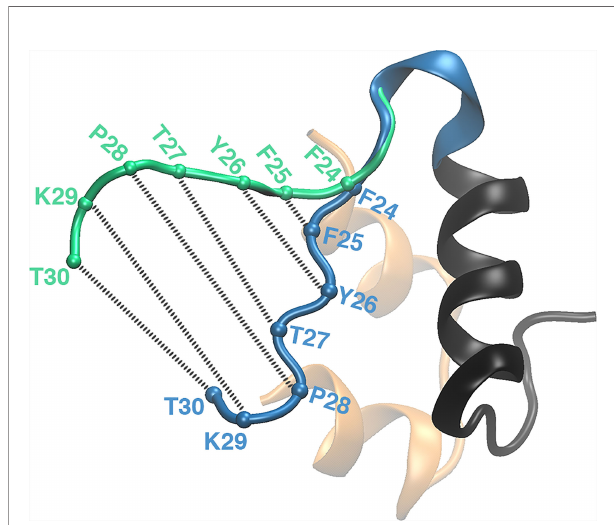
FIGURE 5 | The zipper-like opening of the BC-CT with a hinge at F24. The BC-CT in its closed (inactive) and wide-open (active) conformations is shown in blue and green cartoon representations, respectively. The C a atoms of the corresponding residues are represented by colored spheres. Reprinted from Papaioannou et al. (100), an open access article distributed under the terms of the Creative Commons Attribution License (http://creativecommons.org/